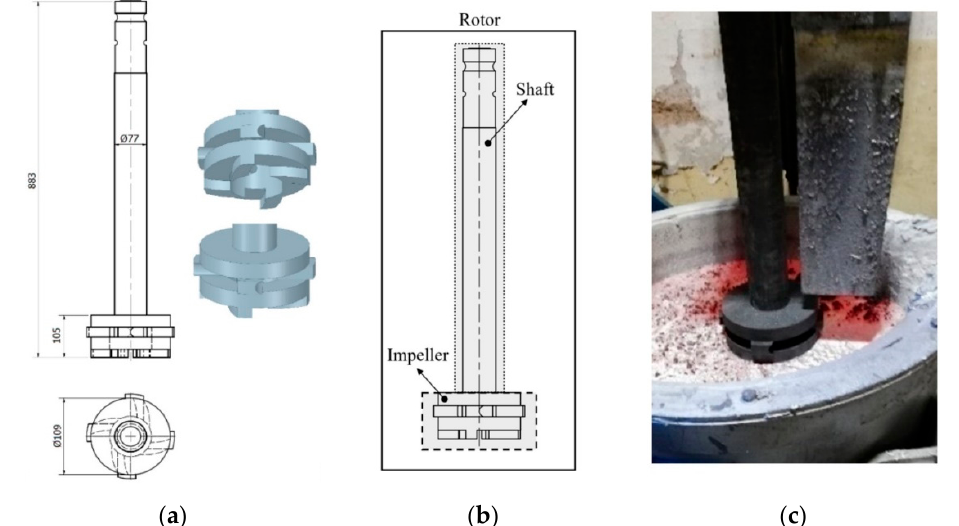
Figure 1. View of: ( a ) Dimensions of tested rotor (mm); ( b ) Description of tested rotor; ( c ) Use of rotor in operational